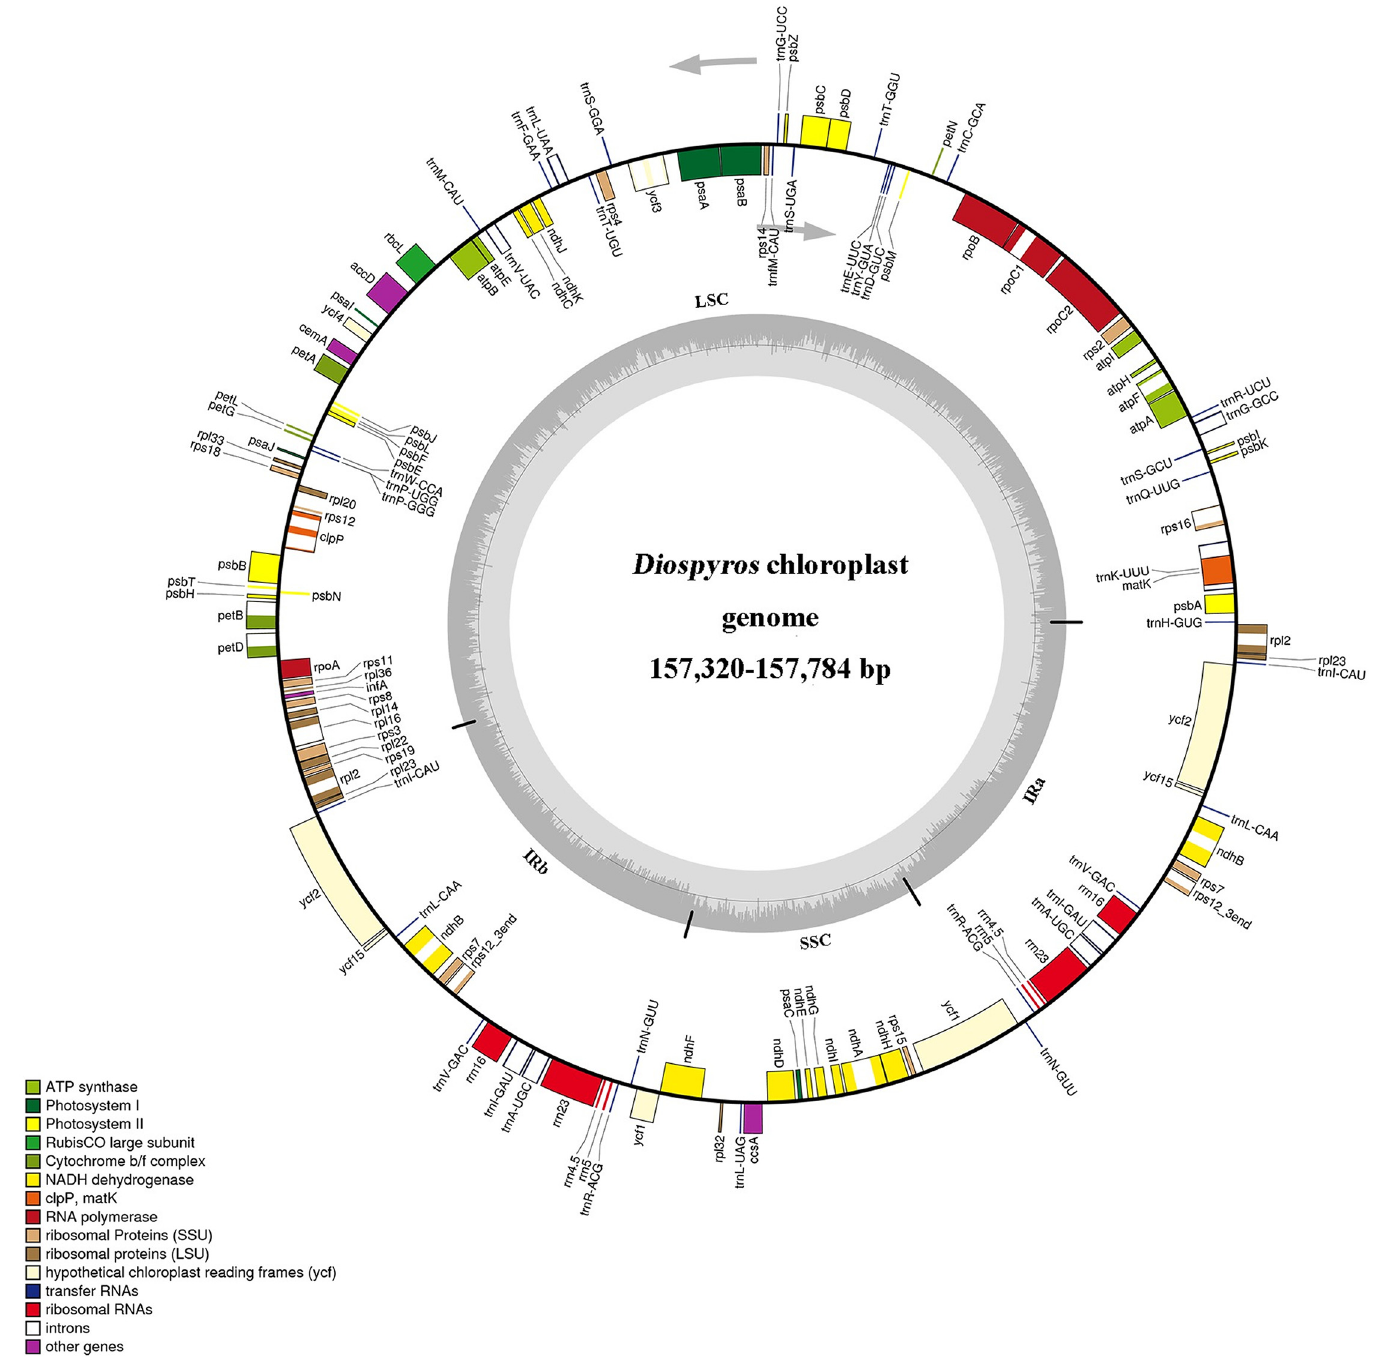
Fig 1. Gene maps of Diospyros chloroplast genomes. Genes on the outside of the large circle are transcribed clockwise and those on the inside are transcribed counterclockwise. The genes are color-coded based on their function. Dashed area represents the GC composition of the chloroplast genome.